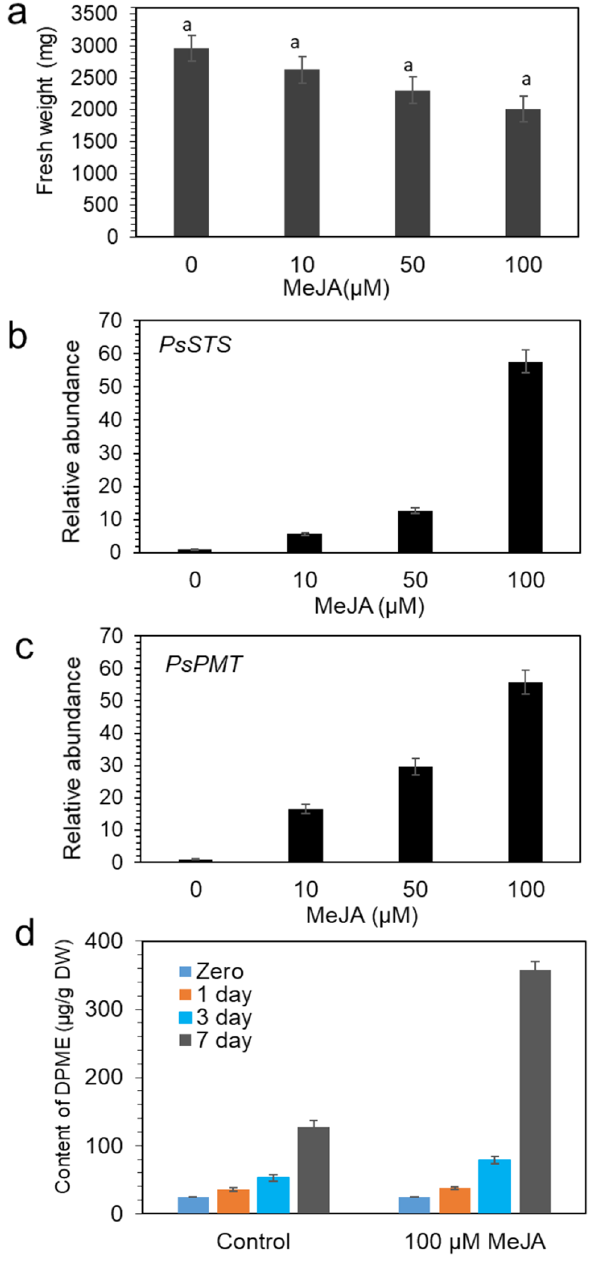
Figure 7. Growth of callus, accumulation of pinosylvin strilbene and expression of genes involved in pinosylvin strilbene biosynthesis in the different concentrations of MeJA. ( a ) Growth of calli grown in different concentrations of MeJA after 4 weeks of culture. ( b,c ) qPCR analysis of PsSTS and PsPMT genes in P. strobus callus. The qPCR data were normalized to β-actin gene expression. The vertical bars indicate the SE based on three biological replicates. ( d ) DPME accumulation in cell suspension during different days of culture in medium with or without 100 µM